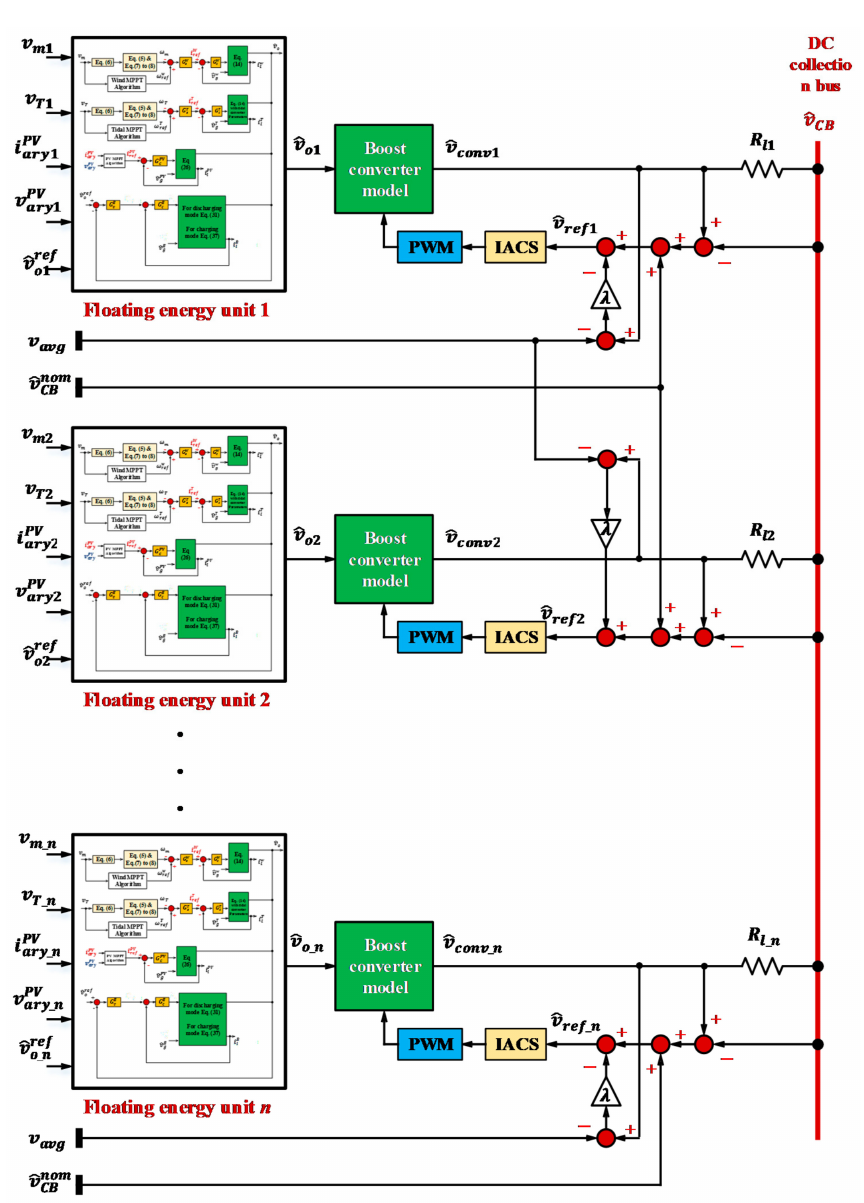
Figure 15. n -parallel floating structures connected to a DC-collection bus with IACS